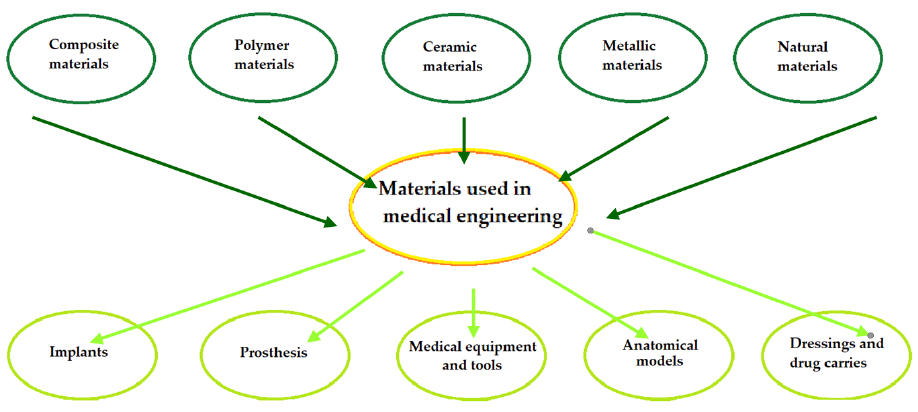
Figure 6. Material classification scheme.